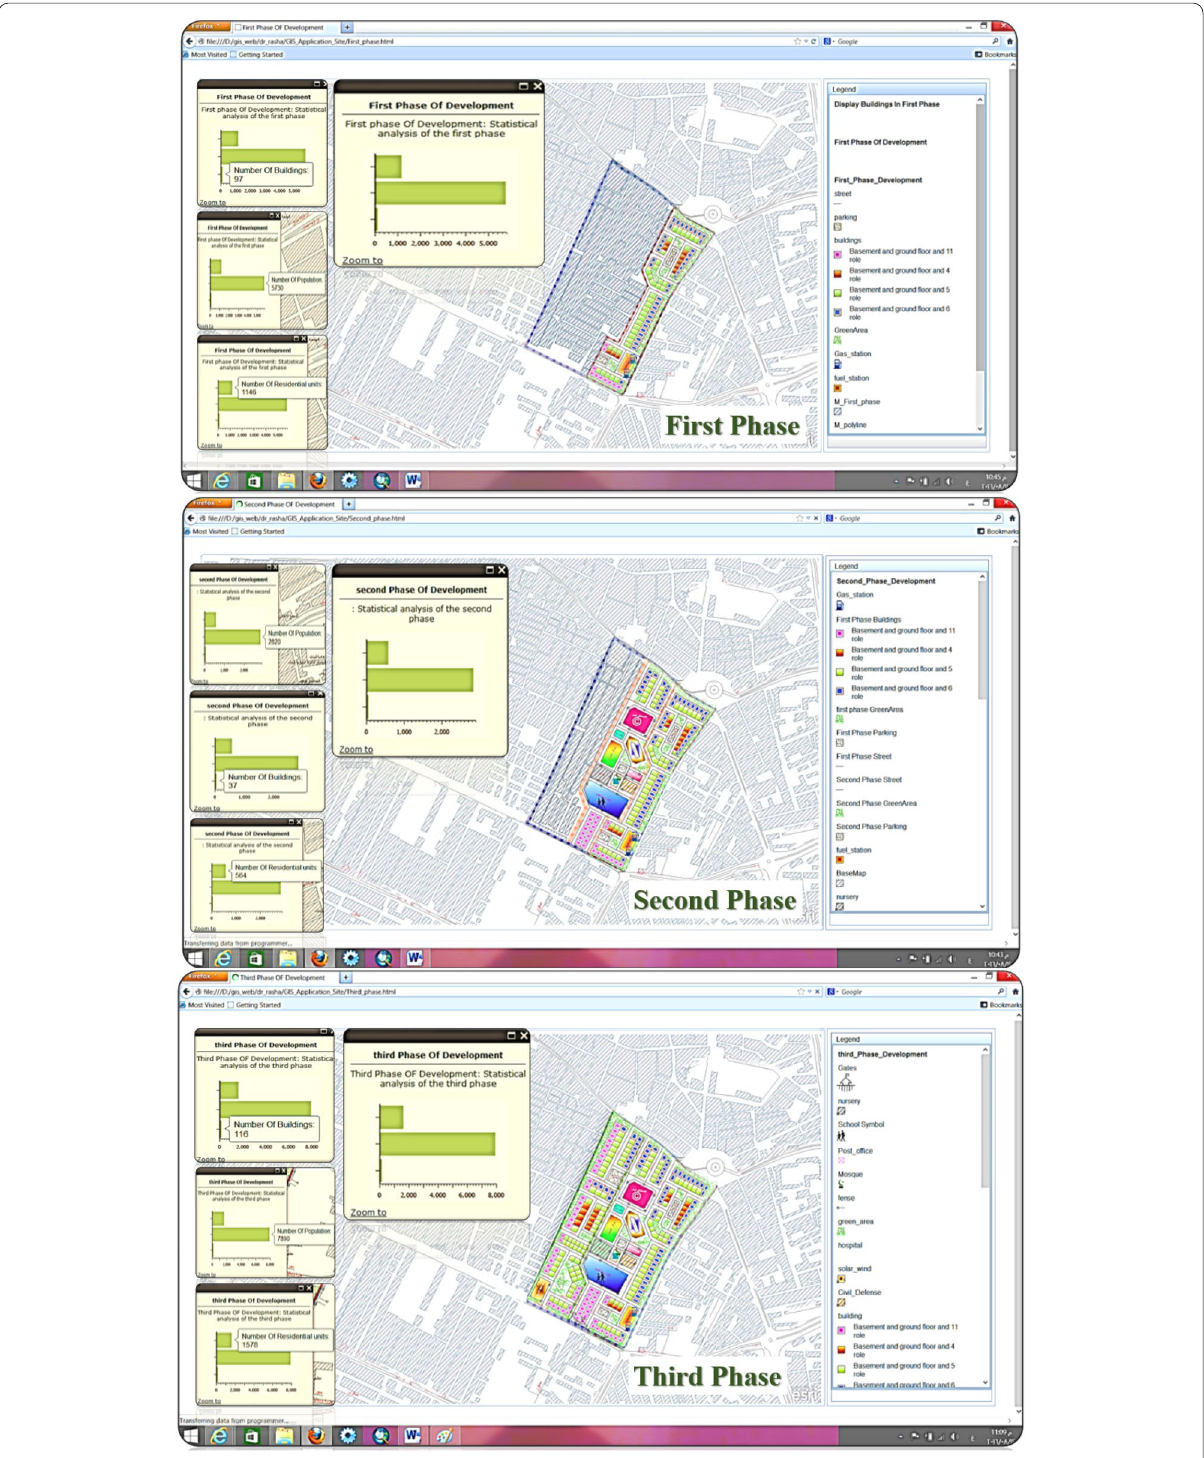
Fig. 8 Three Phases of new sustainable urban development for Ezbet El‑Carama (Previously